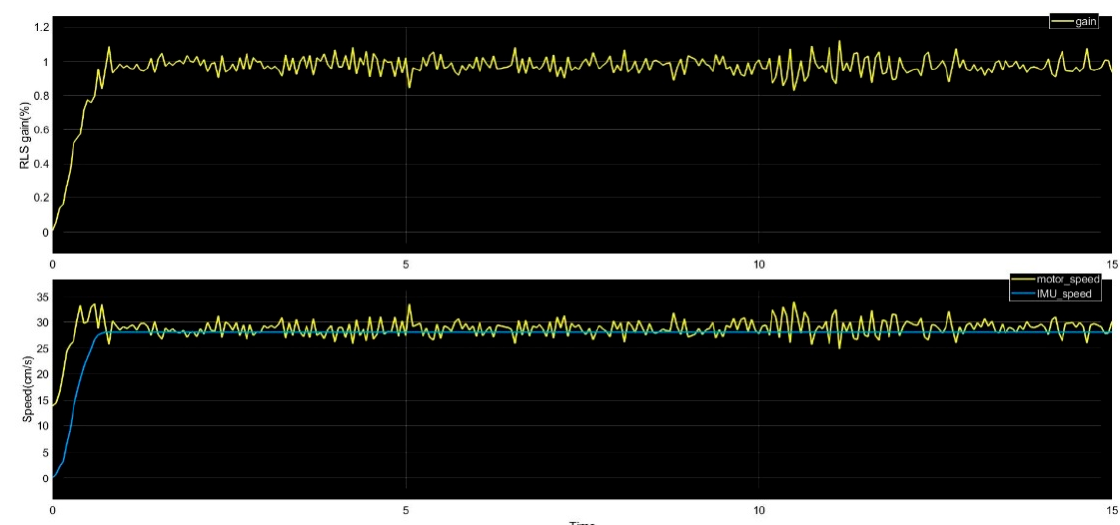
Figure 6. Estimated value by RLS method, motor speeds, and the vehicle speed of the first motor.